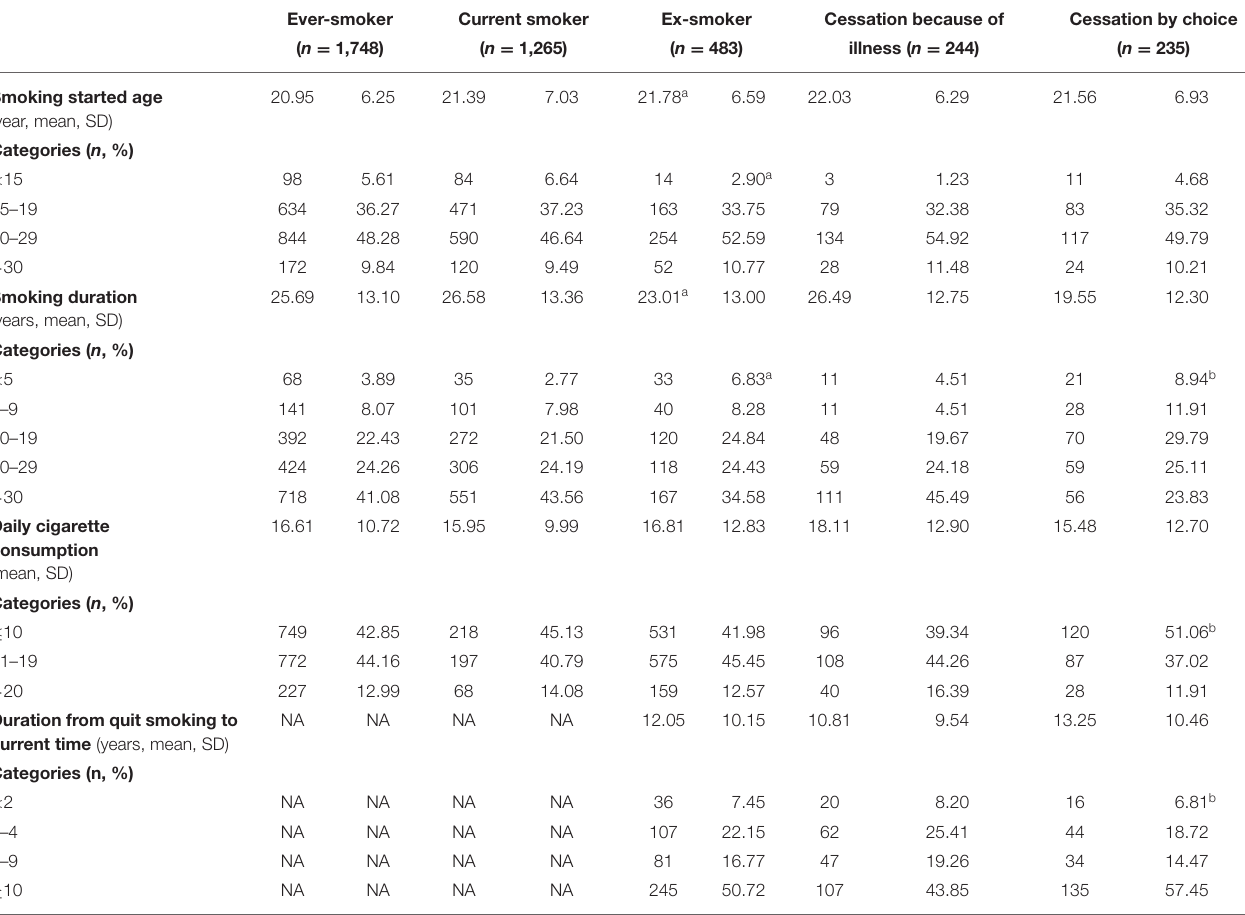
TABLE 2 | Smoking patterns, stratified by smoking status among male subjects in Hebei Province, central China, 2017. Ever-smoker Current smoker Ex-smoker Cessation because